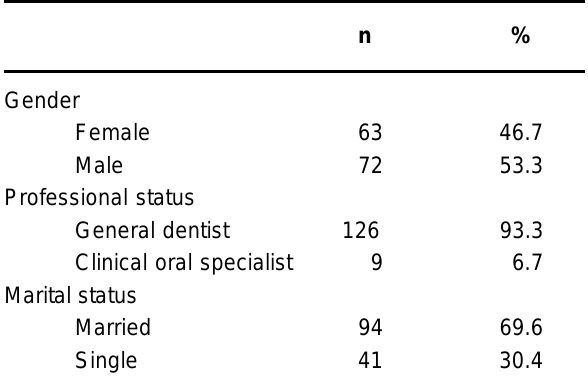
TABLE 1- Sociodemographic characteristics of